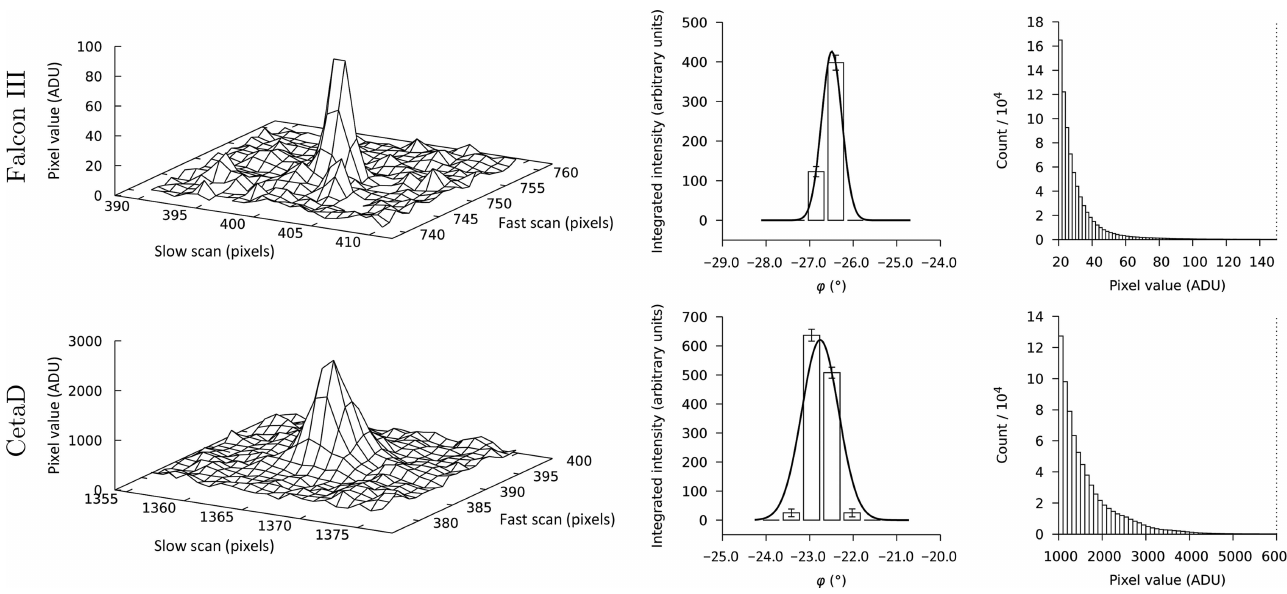
Figure 3 The (10, 16, 12) reflection at (cid:2) 3.3 A˚ resolution on consecutive frames and the distribution of integrated pixel values. Pixel values recorded on the Falcon III (top row; rotation speed d ’ /d t = 0.45 (cid:3) s (cid:4) 1 , (cid:2) ’ = 0.45 (cid:3) per frame) and the CetaD (bottom row; rotation speed d ’ /d t = 0.30 (cid:3) s (cid:4) 1 , (cid:2) ’ = 0.46 (cid:3) per frame) cameras. The central panel in each row shows the profile-fitted intensities as integrated by MOSFLM , where the error bars span one standard deviation of the integrated intensity and a Gaussian function, based on the progression of the reflection through the diffractive condition, has been fitted to aid the eye. For both the Falcon III and the CetaD, the pixel values in a 11 (cid:7) 11 pixel box centered on the predicted spot locations are within the linear range of the detector, limited by the vertical dotted line (right panel). The physical pixel sizes on both cameras are identical (14 m m, square). Note that the peak counts on the CetaD are more than an order of magnitude higher than on the Falcon III, as the Falcon III in integrating mode reports the average pixel values of the individual frames at 40